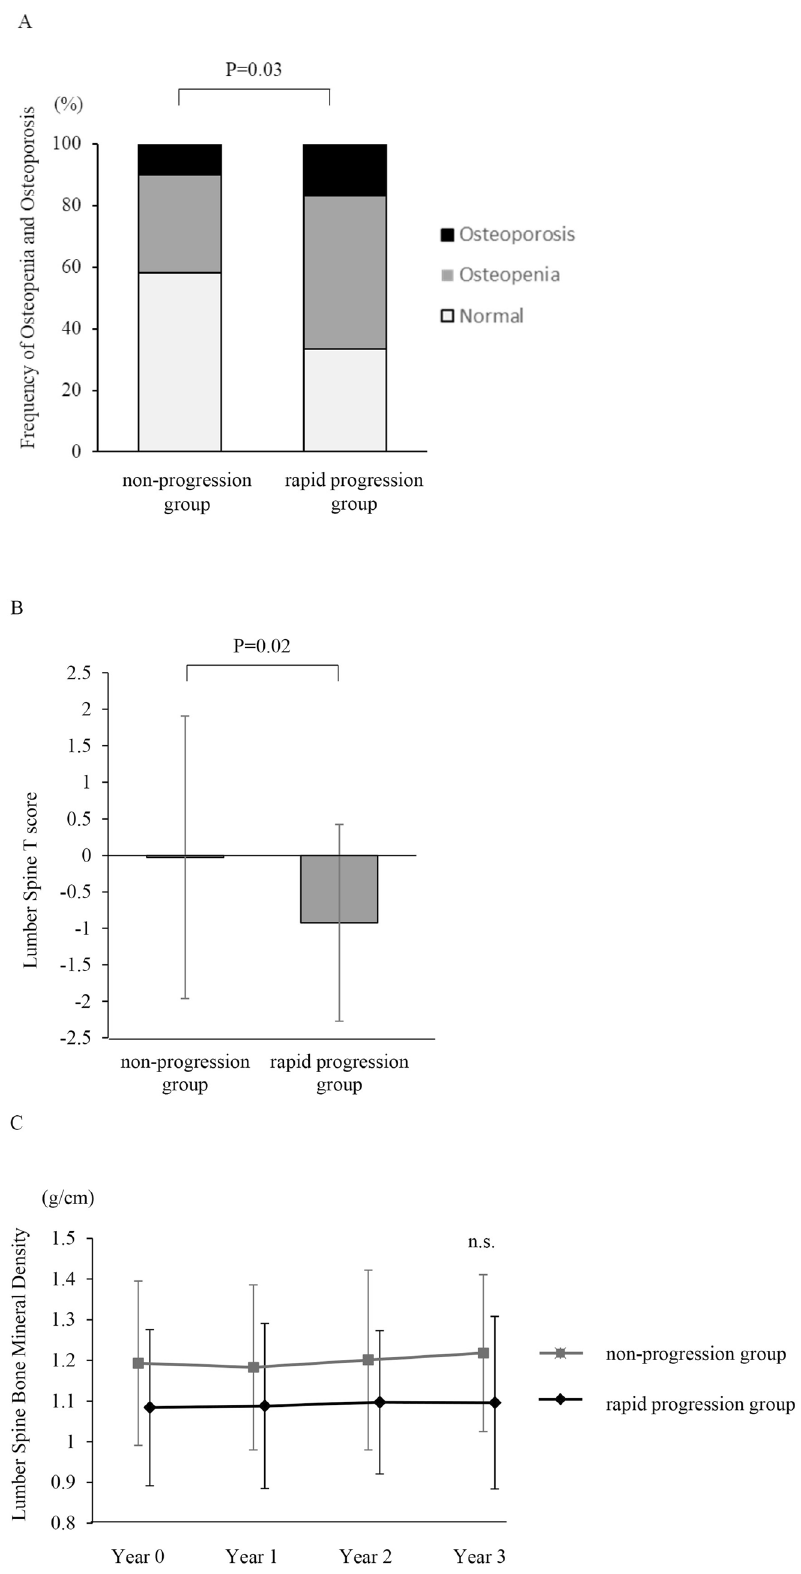
Figure 3. Relationships between lumbar BMD and changes in emphysematous progression in COPD patients. ( A ) Frequency of osteopenia and osteoporosis in the non-progression group and rapid progression group. ( B ) Comparison of baseline T score in the lumbar spine between the two groups. ( C ) Annual change in BMD in the lumbar spine in the two groups over 3 years of follow-up. Data are shown as mean ± SD. BMD bone mineral